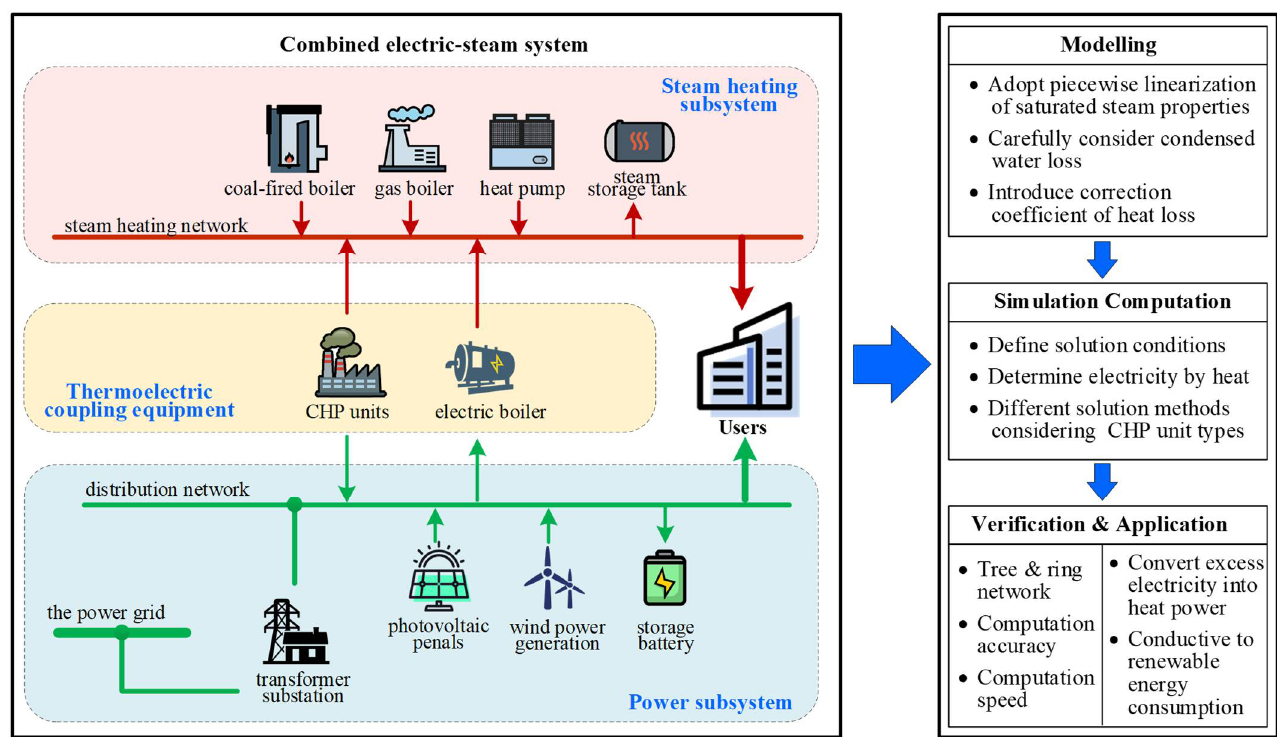
Figure 1. Overview of the proposed simulation approach for